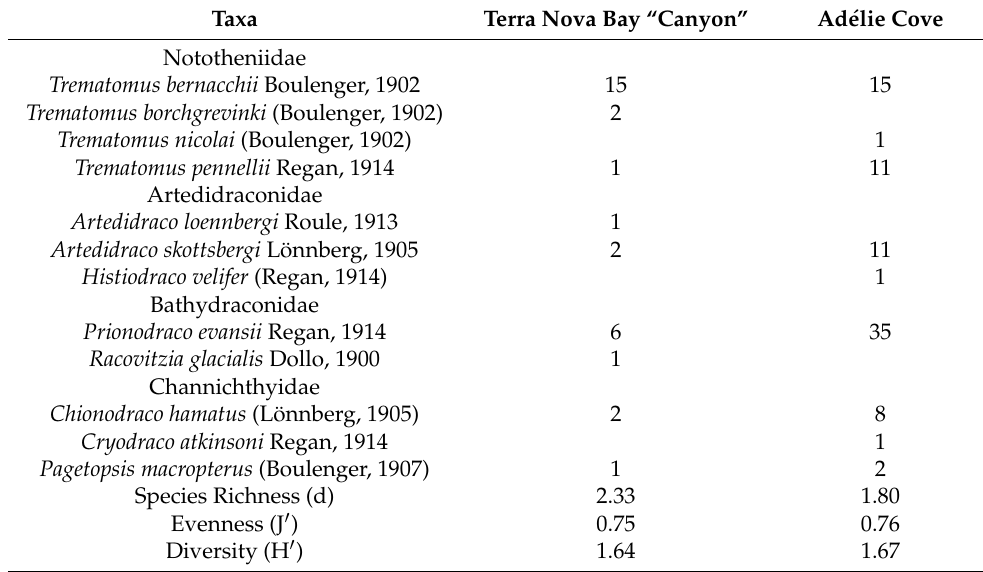
Table 2. Species list, number of individuals, and biodiversity indices calculated for each ROV transect. Taxa Terra Nova Bay “Canyon” Ad é lie Cove